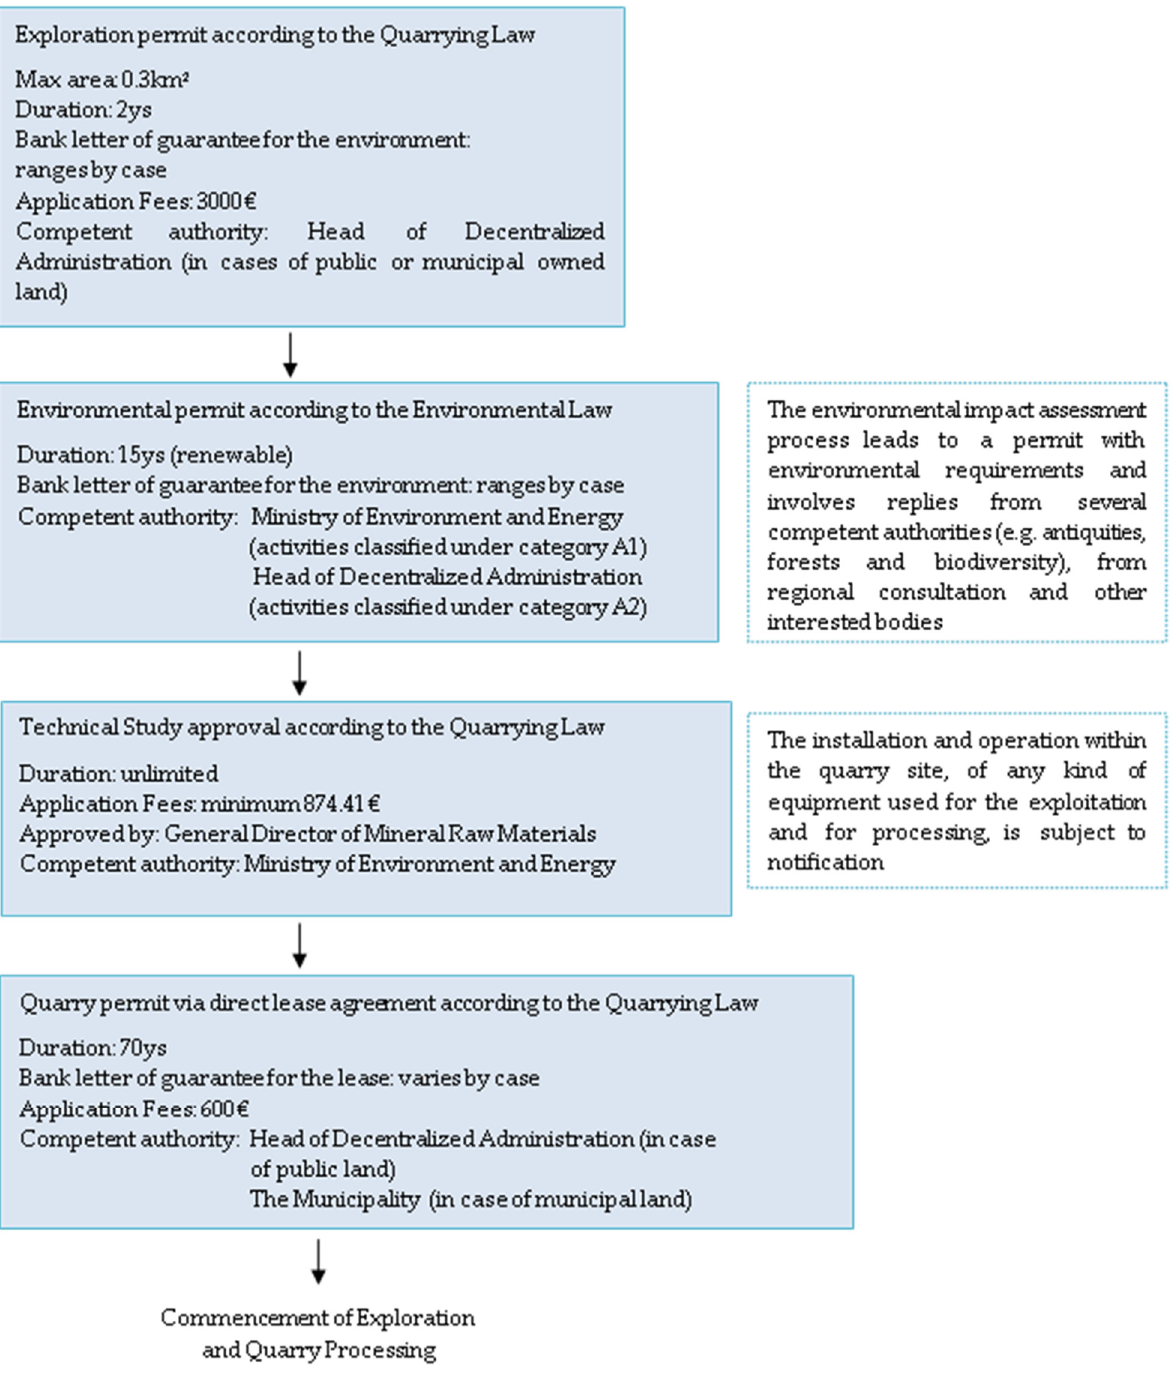
Figure 4. Permitting steps to start up a quarry.